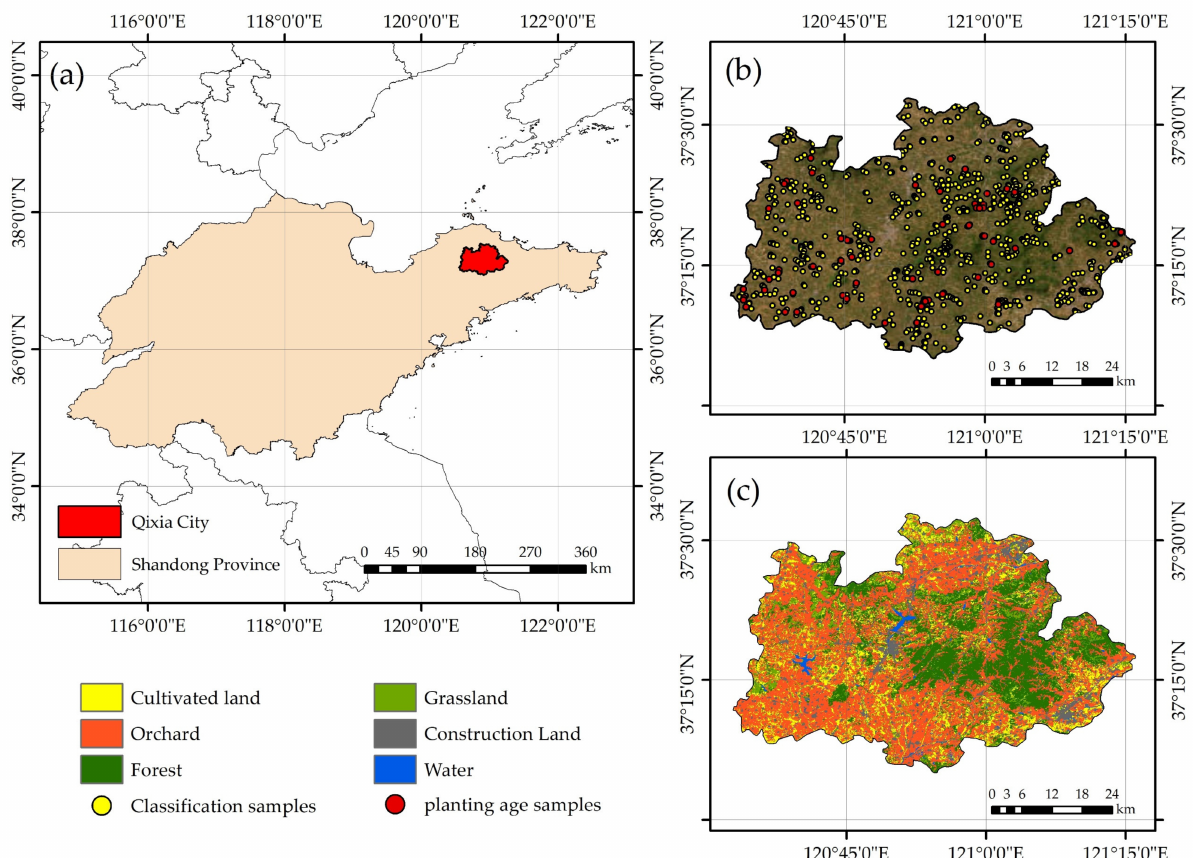
Figure 1. Study area and land use/cover classification result. ( a ) Study area. ( b ) High-resolution remote sensing image of Qixia City and samples. ( c ) The land use/cover classification result of Qixia